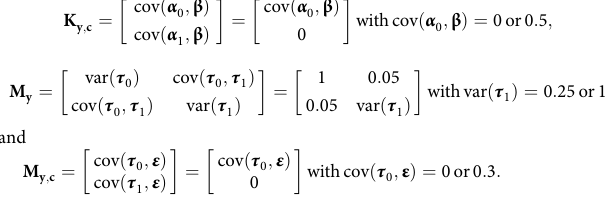
Supplementary Fig. 16. For RR-GREML and GCI-GREML, following Robinson et al. 16 , we strati fi ed SMK into four levels: 8,773 individuals with SMK > 0.8, 9,192 individuals with 0.5 ≤ SMK ≤ 0.8, 11,741 individuals with 0< SMK< 0.5, and 36,575 individuals with SMK = 0 (i.e., never smoked). Neuroticism score (NEU) : The neuroticism score (data fi eld 20127) of a given individual was indexed by the number of ‘ yes ’ s to 12 touchscreen questions